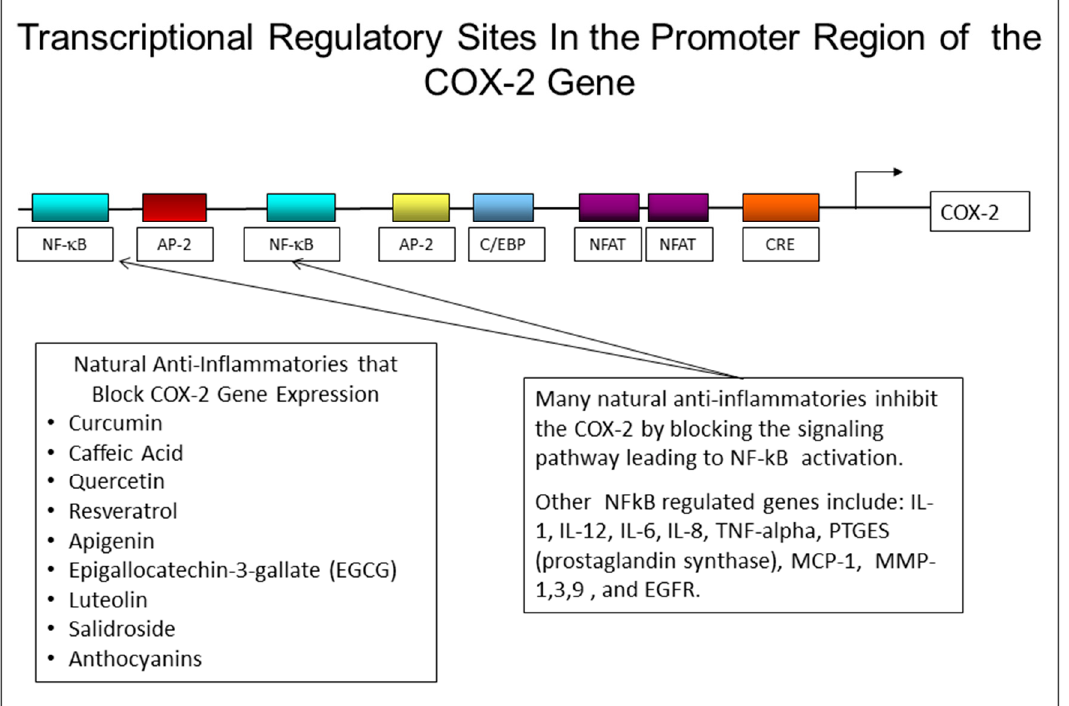
Figure 4. The promoter region of the COX-2 gene showing the binding sites for the transcription factors, NF-kB, NFAT, AP-2 binding site, the c/EBP site, and the CRE site that binds the cyclic AMP response element binding protein (CREB) transcription factor. The NF-kB sites play a significant role in the up-regulation of the COX-2 gene since this transcription factor can be activated through several signaling pathways including those used by IL-1 and TNF-alpha.